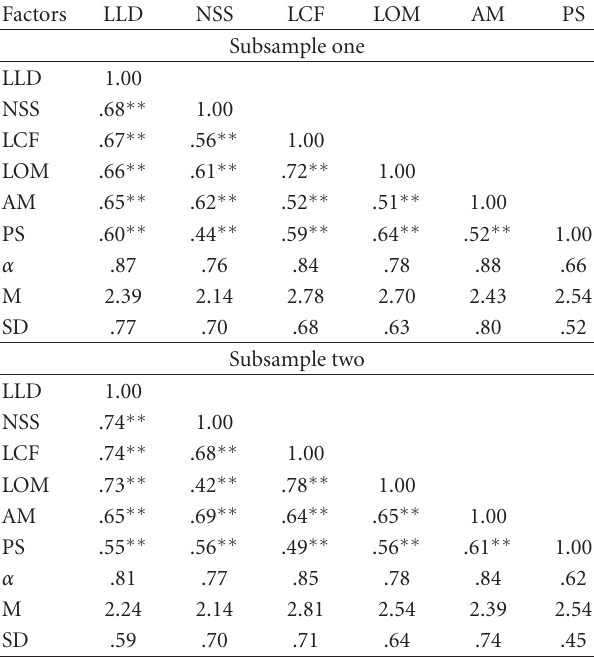
Table 3: Correlations, reliabilities, and descriptive statistics of the six factors for the Subsample one (English) and Subsample two. Factors